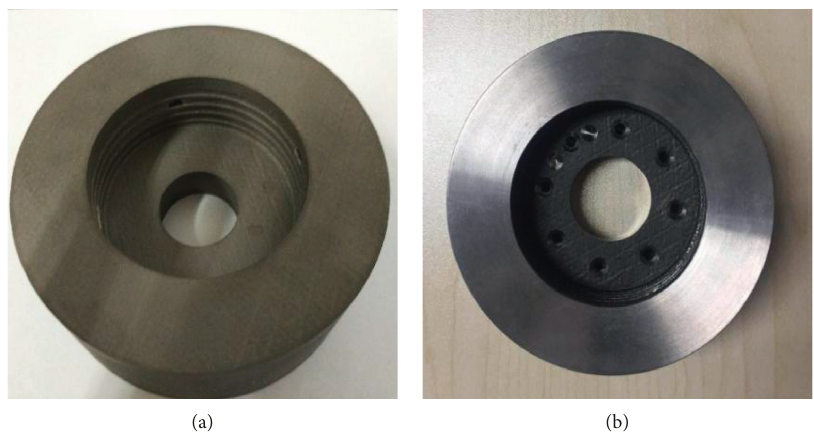
Figure 13: Titanium alloy integrated balancing terminal. (a) Before modification. (b) After modification.